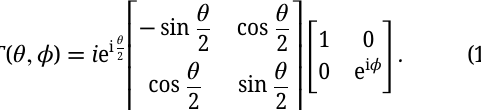
and 2 f , to avoid 0 0